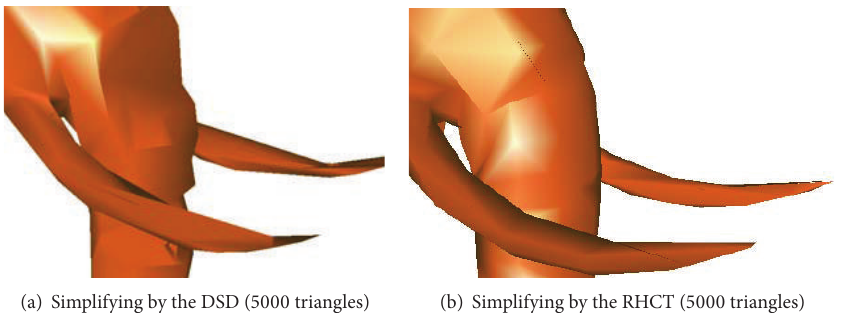
Figure 14: The elephant trunk is damaged and even hollow when simplifying by the DSD.